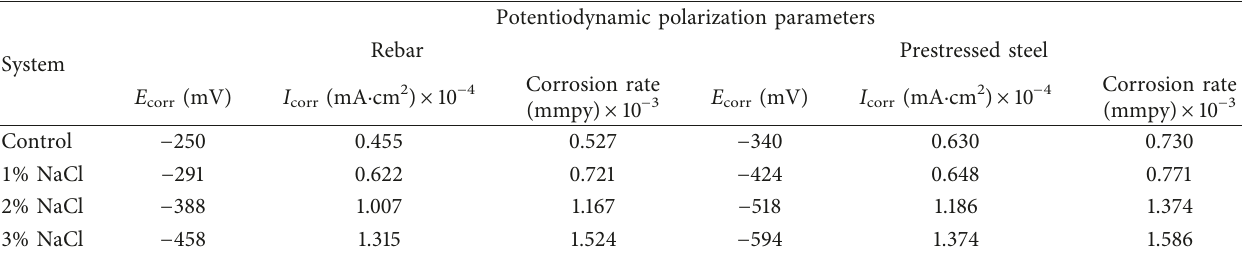
Table 5: Potentiodynamic polarization parameters for the rebar and prestressed steel in chloride-contaminated concrete.